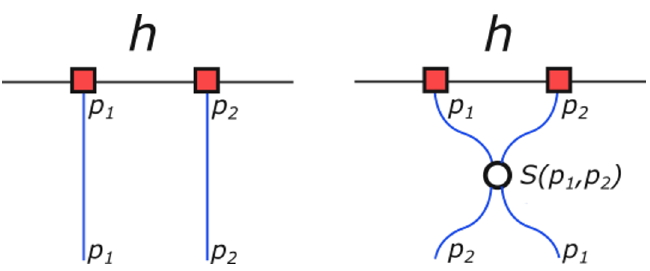
Figure 3 . The Watson equation relates two expressions for the form factor, one of which involves the full S matrix of the theory, complete with dressing factors — in this case, S AdS 3 × S 3 × T 4 ( p, q )